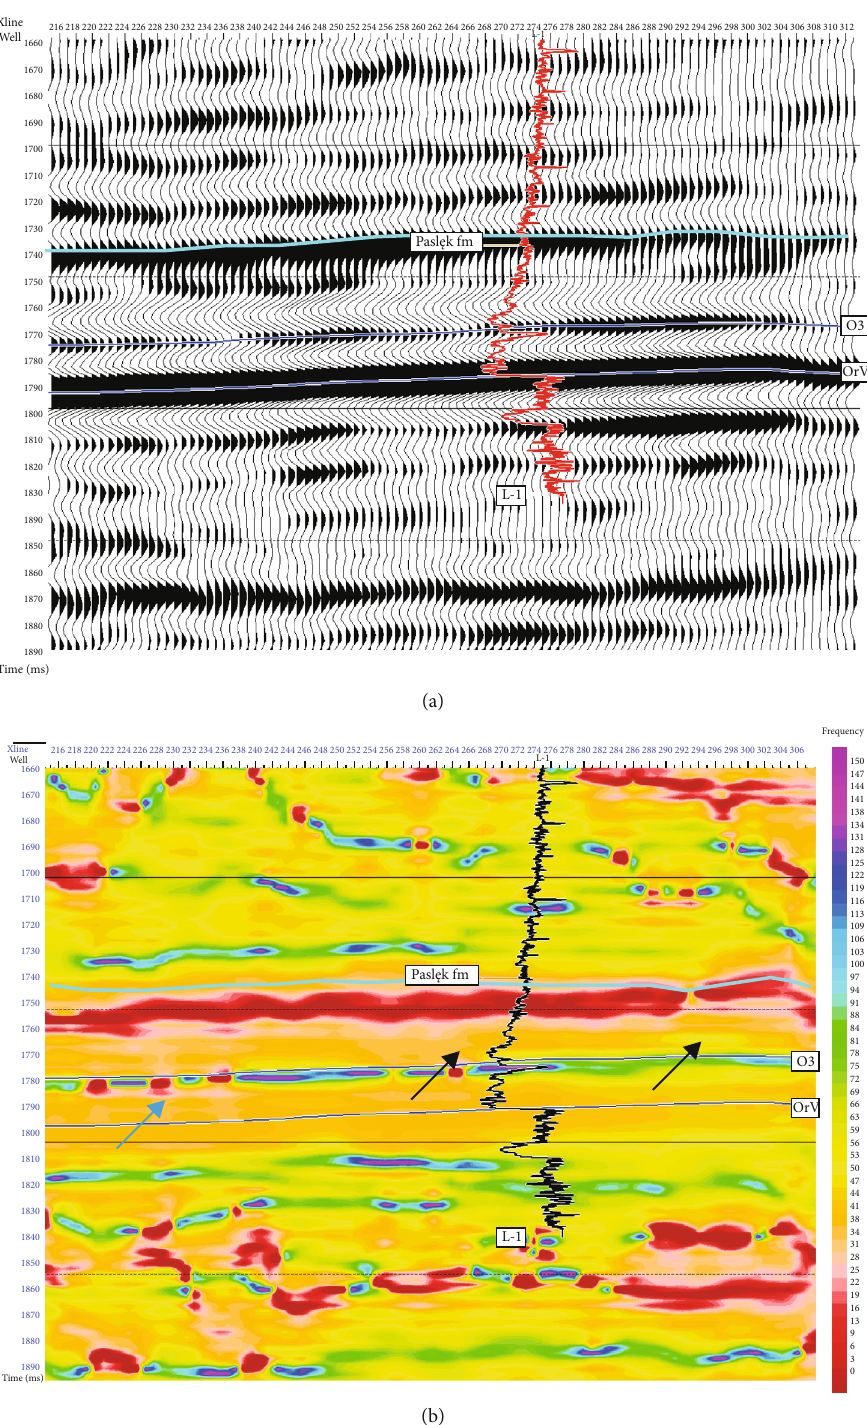
Figure 9: Zoomed seismic pro fi le that goes through the well: (a) migrated seismic section, (b) instantaneous frequency attribute. The curve is P wave velocity. In (b), red colours indicate lower frequencies, and purple indicates higher frequencies. Horizons ’ marks are O3: the top of the Prabuty formation and Orv: top of the Kopalino formation. Black arrows indicate the characteristics of the low frequency anomaly (described in text), and blue arrow indicates tuning e ff